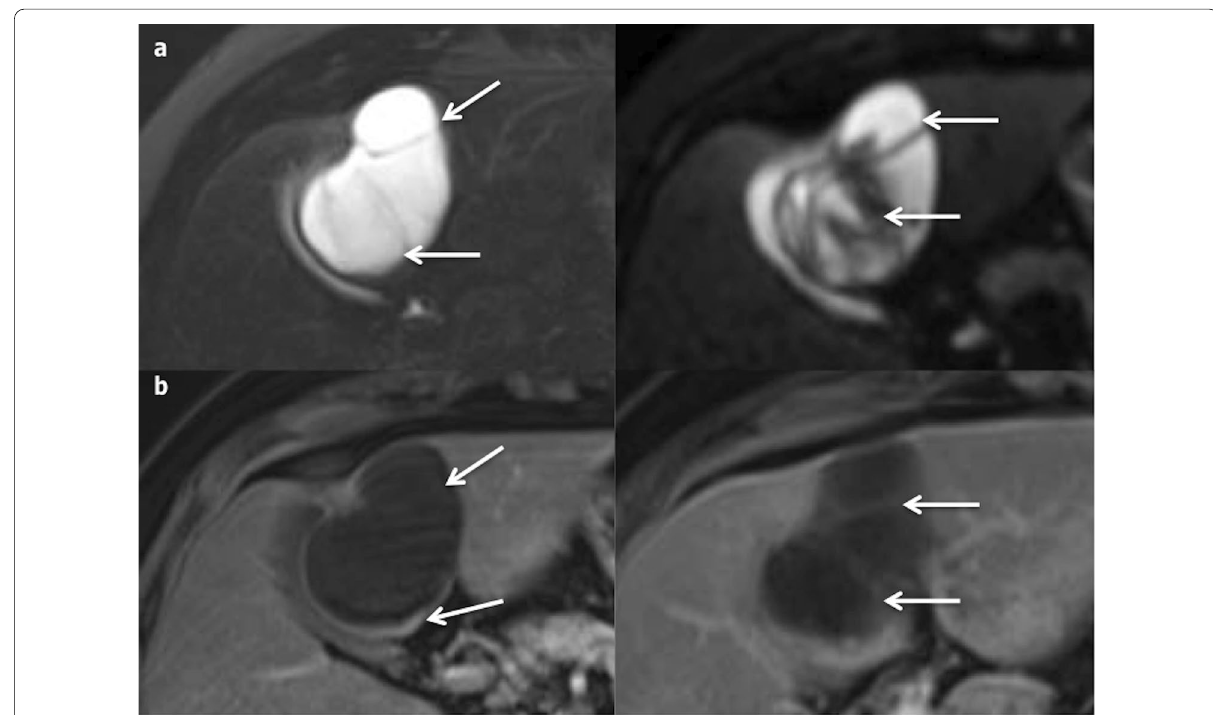
Fig. 19 Typical non-invasive mucinous cystic neoplasm of the liver in a 59-year-old female. a Axial T2-weighted magnetic resonance imaging shows a solitary hyperintense cystic lesion, with hypointense septa (arrows). b Axial T1-weighted magnetic resonance imaging on portal venous phase depicts the enhancement of the capsule and septa